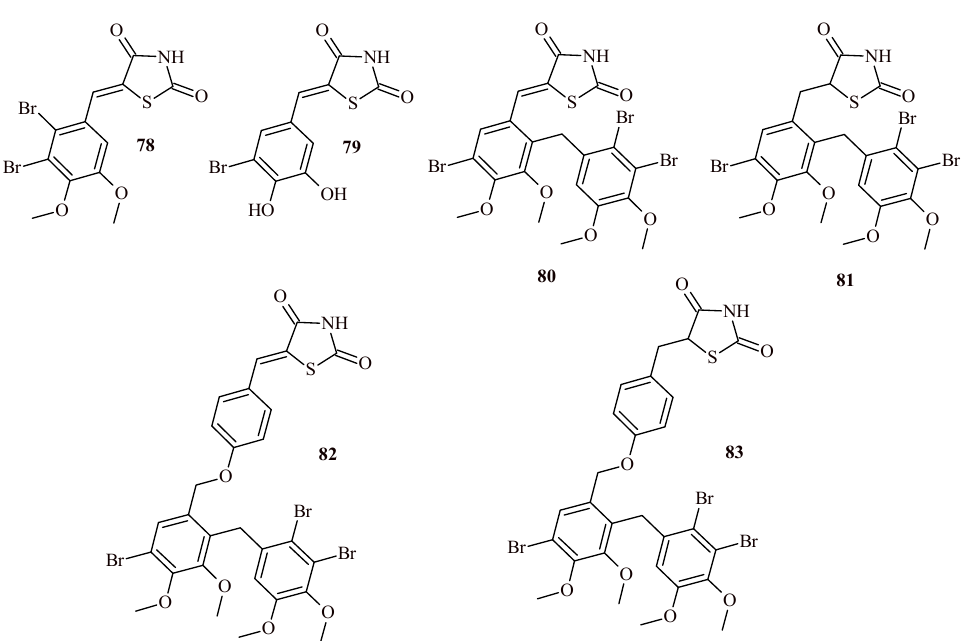
Figure 34. The 5-(Bromobenzylidene)thiazolidine-2,4-dione derivatives ( 78 – 80 and 82 ) and their saturated analogues ( 81 , 83 ) as potential protein tyrosine phosphatase 1B inhibitor with antidiabetic properties.